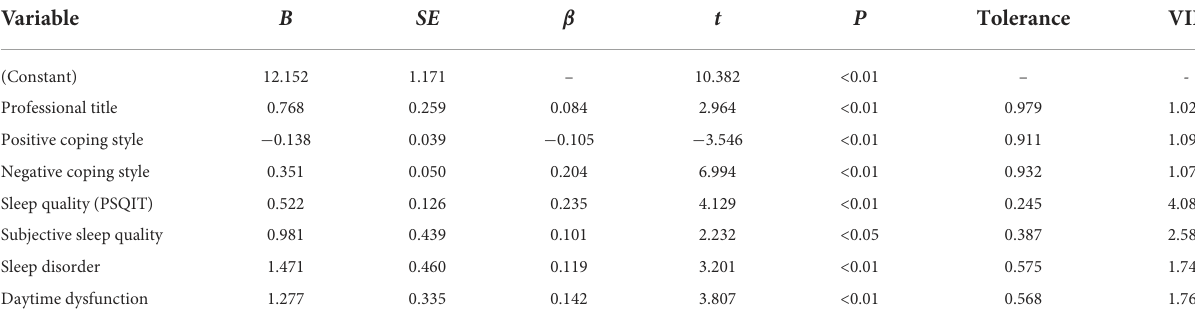
TABLE 4 Predictors factors of psychological distress in psychiatric nurses ( n = 812, Shandong, China). Variable